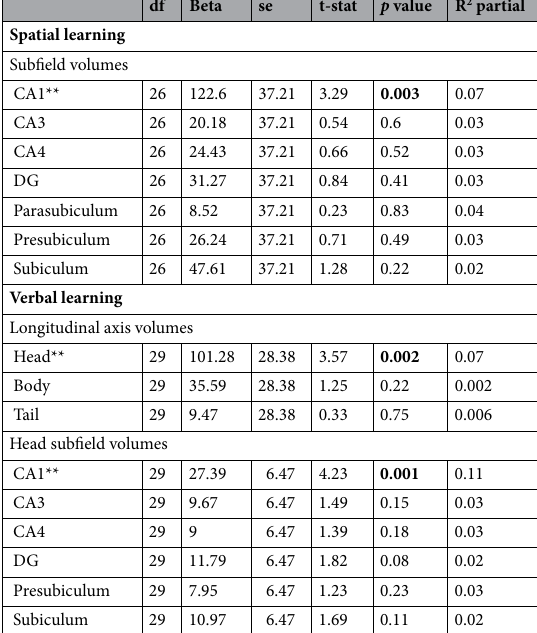
Table 3. Association between spatial and verbal learning on hippocampal volumes. Table of the associations between spatial and verbal learning and hippocampal subfields using linear mixed effect models. ** p < 0.007. Bold text reflects significant p -values after Bonferroni